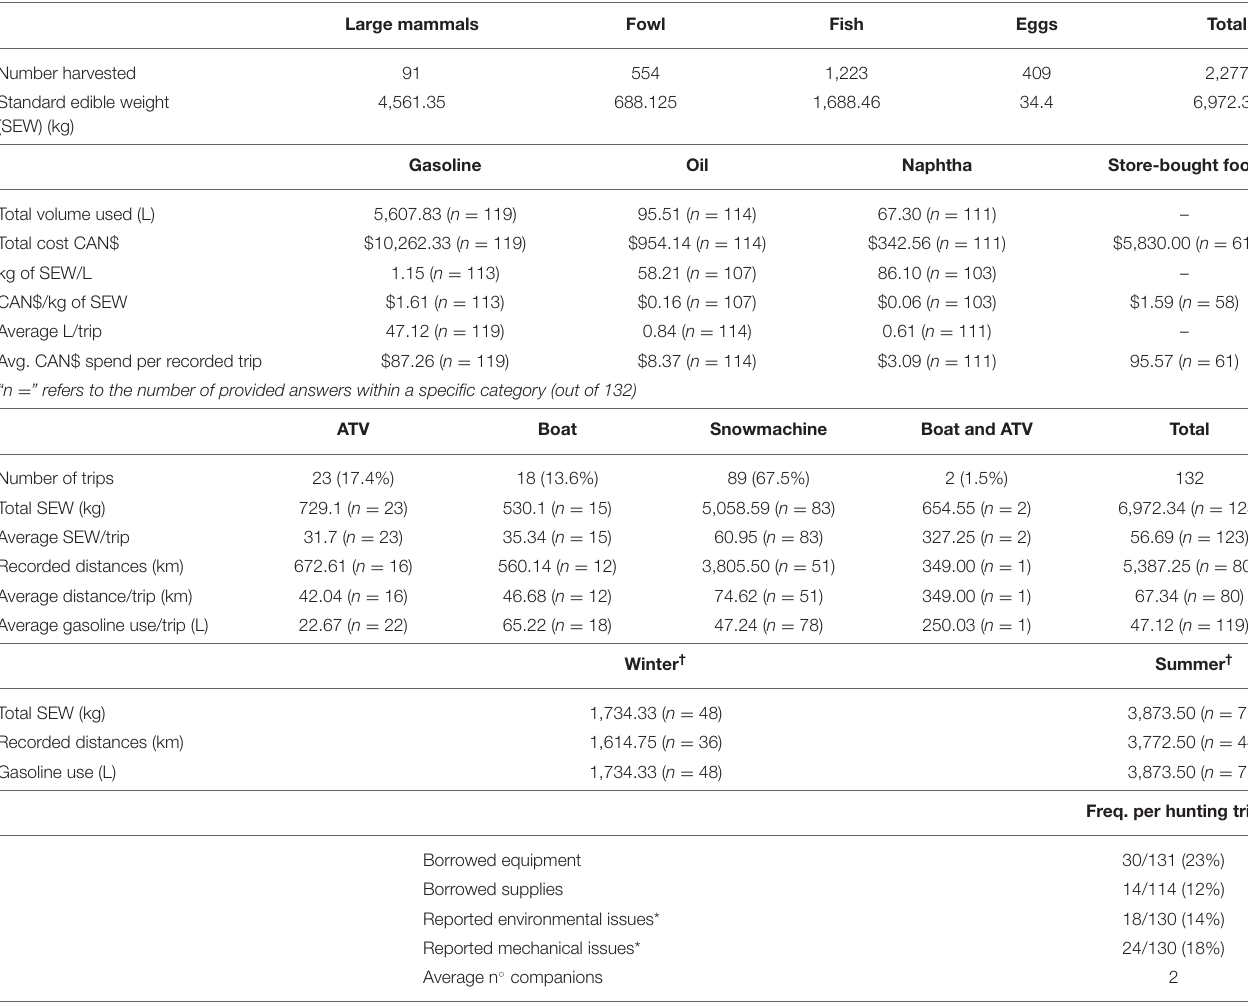
TABLE 2 | Summary of descriptive statistics derived from GPS tracking and interviews; DERIVED. Large